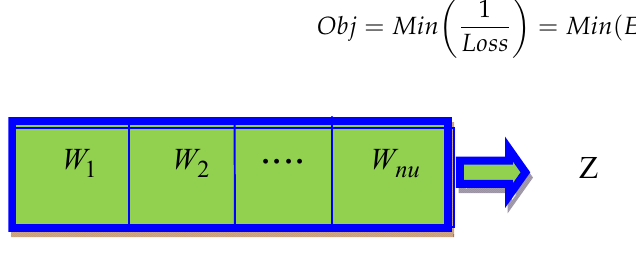
Figure 3. Solution encoding for optimal weight selection.